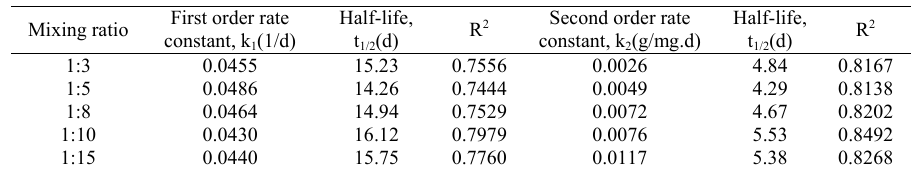
Fig. 6: Trend of (a) the TKN, (b) TP, (c) C: N and (d) C:P changes during the IVC process Table 4: kientic models for biodegradation of TPH using IVC Fig. 5: pH profile during IVC for removing